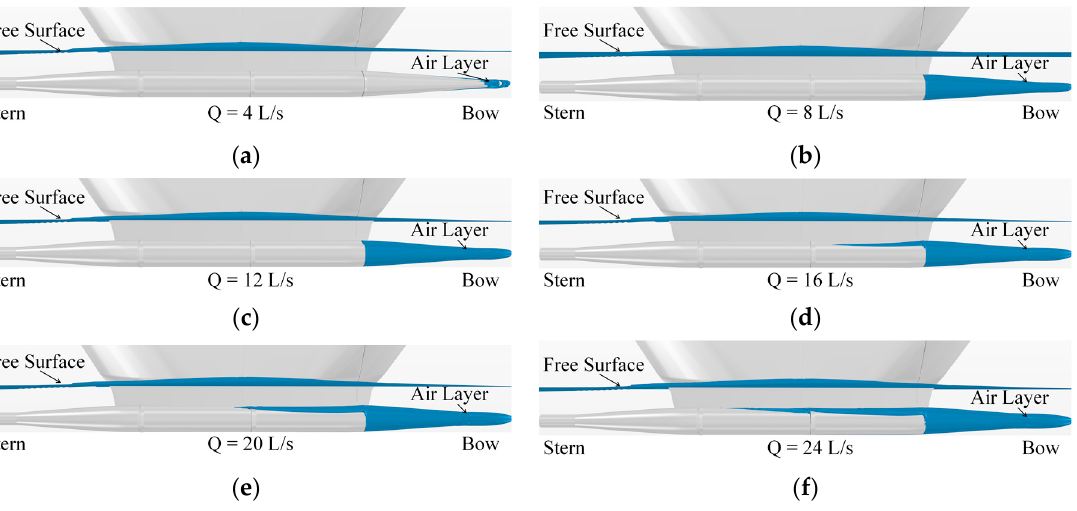
Figure 7. Air layer distribution with air injected from location L1: ( a ) Air fl ow rate Q = 4 L/s; ( b ) Air fl ow rate Q = 8 L/s; ( c ) Air fl ow rate Q = 12 L/s; ( d ) Air fl ow rate Q = 16 L/s; ( e ) Air fl ow rate Q = 20 L/s; ( f ) Air fl ow rate Q = 24 L/s.